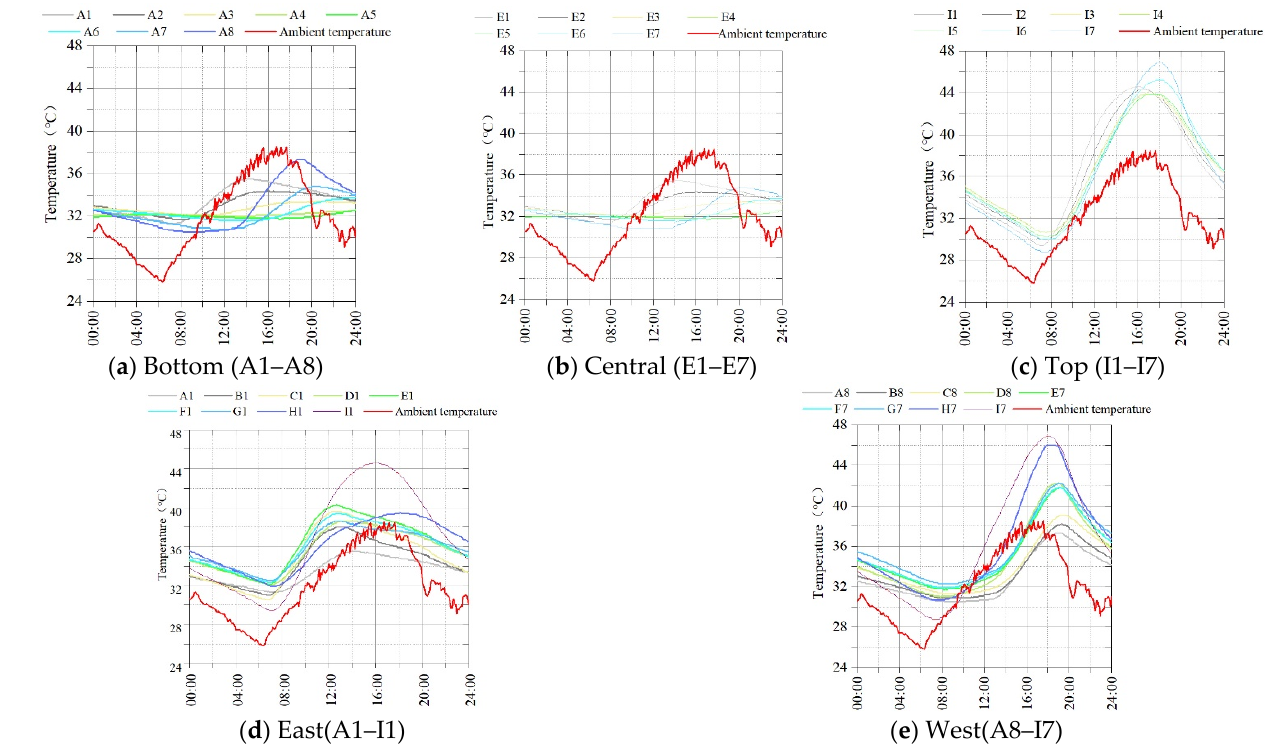
Figure 21. Variation of wall temperature during the highest atmospheric temperature throughout the year (13 July 2017).